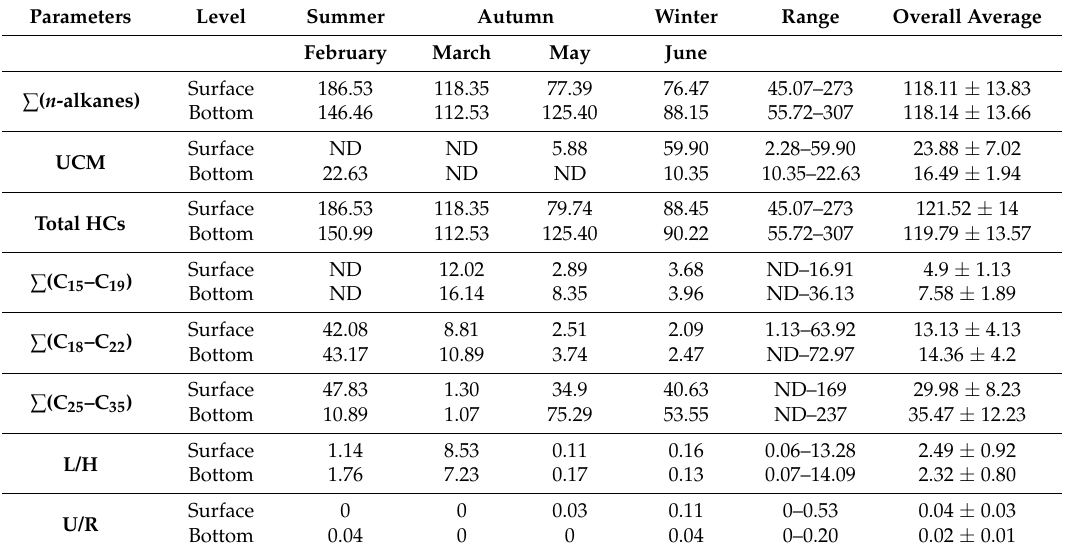
Table 5. Mean concentrations of hydrocarbons in the Algoa Bay water ( µ g/L) and diagnostic ratios.